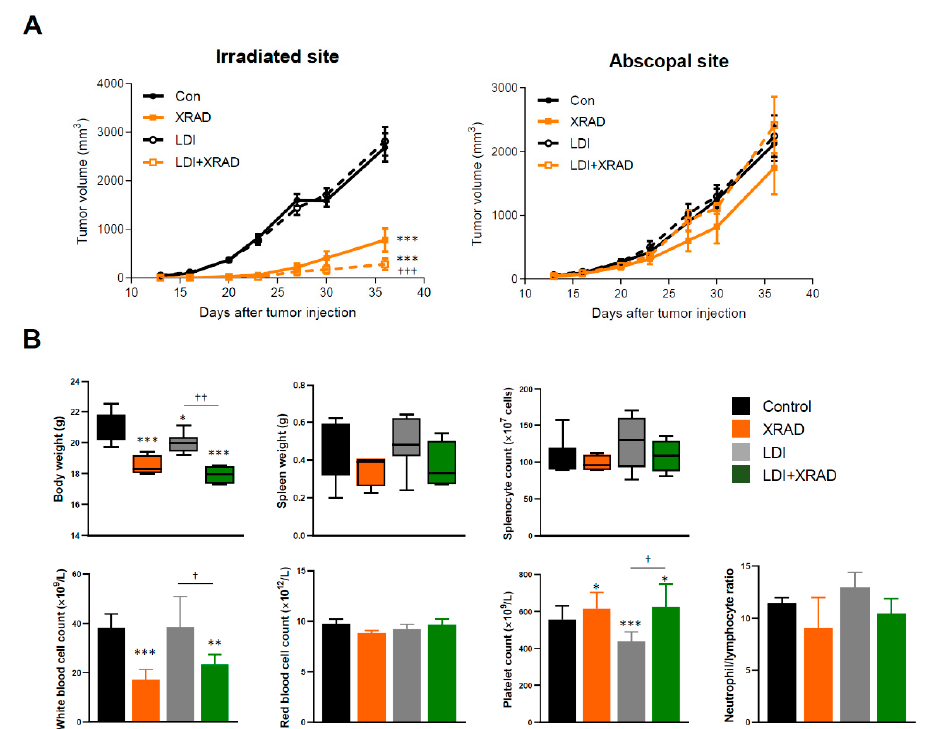
Figure 6. LDI-mediated abscopal response was not applied to immunodeficient mice. ( A ) Tumor growth was monitored with irradiated and abscopal tumors in each group. ( B ) Body and spleen weight were measured at the end of the experiment. Splenocyte number was determined using a Trypan blue exclusion assay. Whole blood was drawn by retro-orbital puncture and analyzed using a VETSCAN HM5 hematology analyzer. Data represent means ± SEM of 6–8 mice per experiment. * p < 0.05, ** p < 0.01, *** p < 0.001 vs. control, † p < 0.05, †† p < 0.01, ††† p < 0.001 vs. LDI.